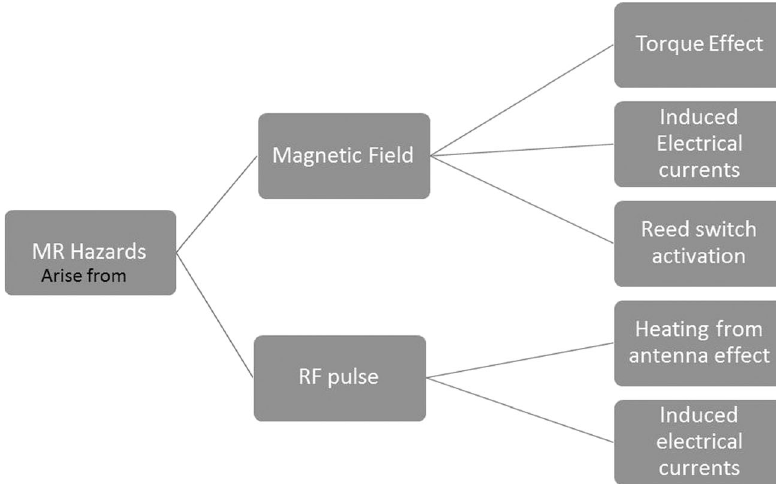
Fig. 1 MR hazards which pose a risk to patients with MRI unsafe compatible